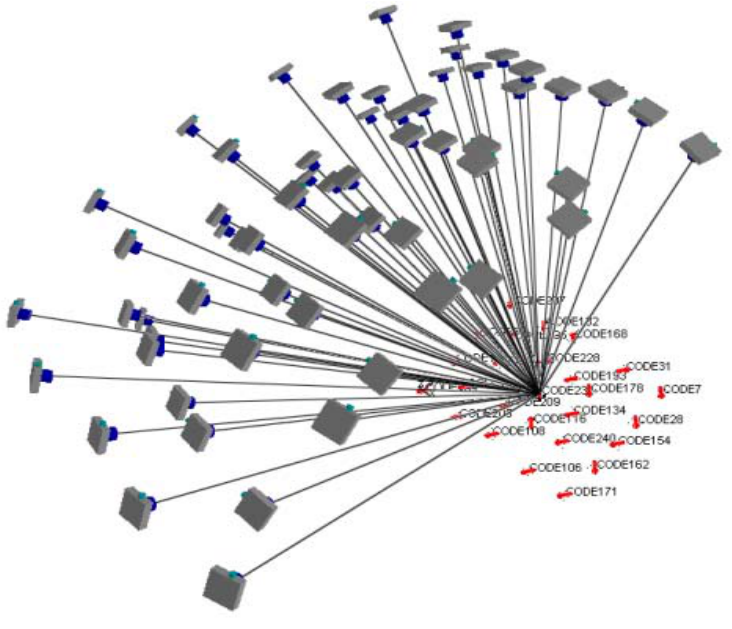
Figure 8. Convergent bundles for the 1 × 5 multi-camera